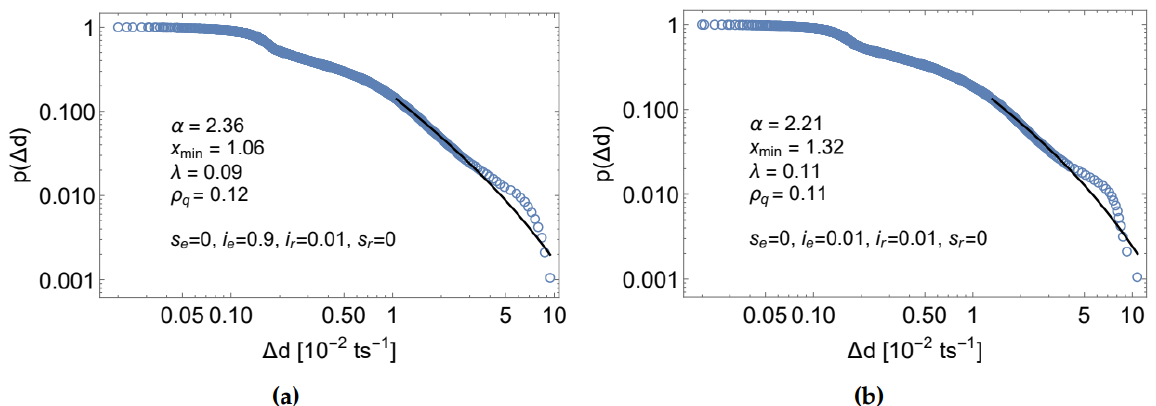
Figure 6. Log-log scale plots of ∆ d per 100 ts in CCM. The black lines represent the corresponding truncated power law fits. The insets show the fit parameters as well as the scenario configurations. The plots ( a , b ) differ by the scenario configurations shown in the insets. These scenarios are among the best swarm performances with respect to ω e